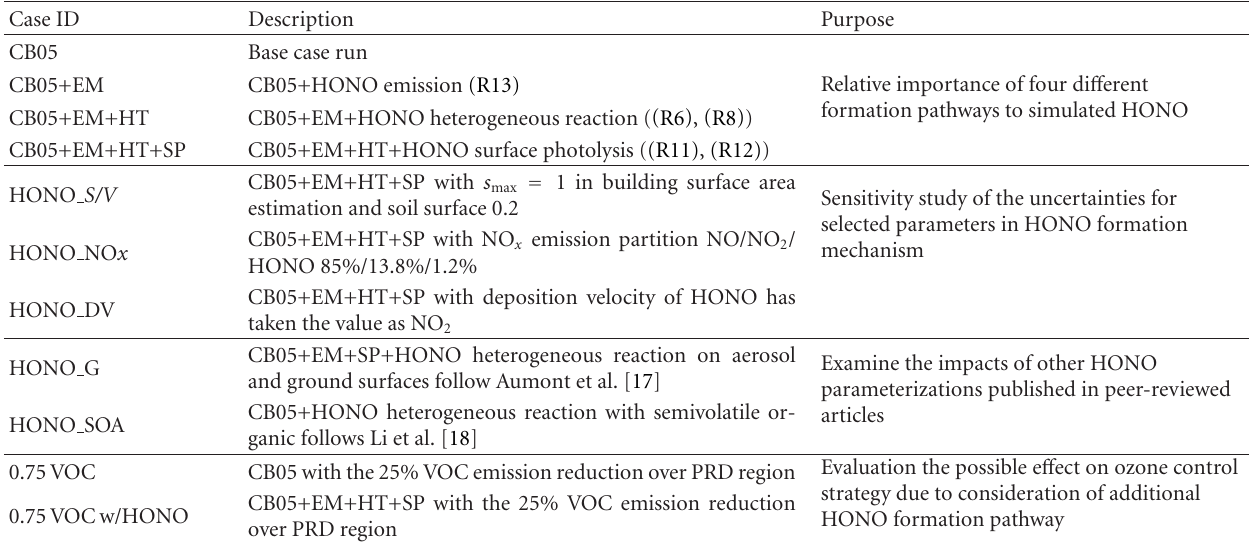
Table 1: Design of CMAQ simulation case to evaluate the HONO